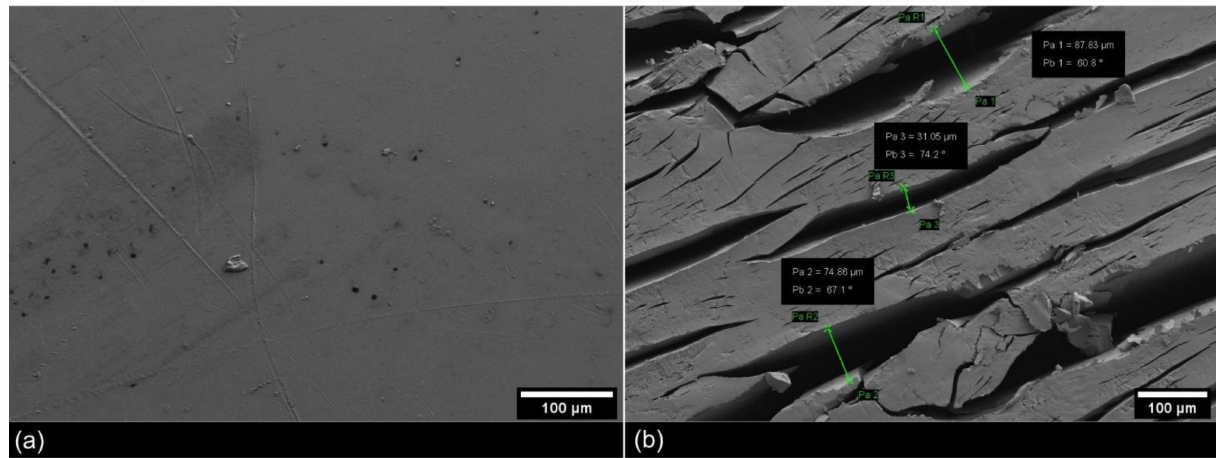
Figure 6. FESEM images of PE chips before and after UV-weathering. Images show the surface of an ( a ) unweathered PE chip and ( b ) the surface changes after 812 h of UV radiation at elevated temperature (60 ◦ C) and 85% relative